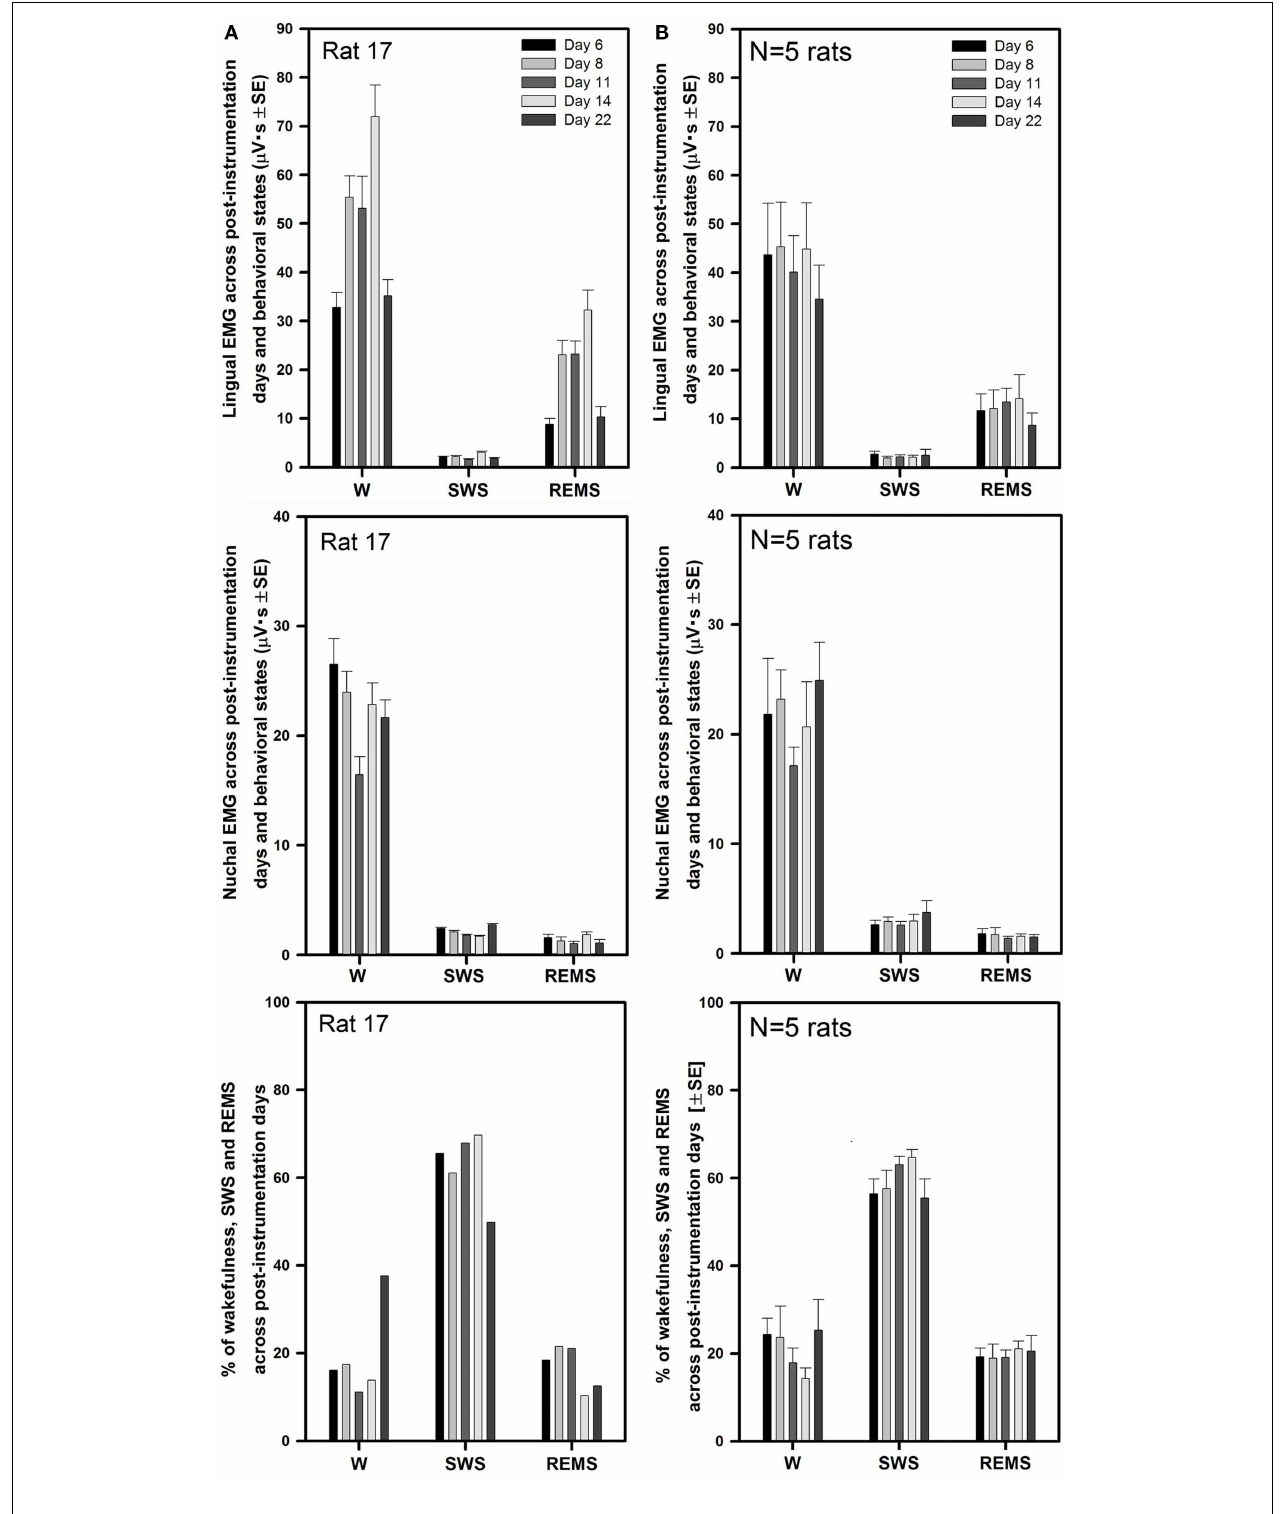
FIGURE 3 | Stable levels of lingual and nuchal EMGs across successive recording days in rats with intact upper airway . (A) Lingual and nuchal EMG levels quantified separately during different sleep–wake states, and the percentage amounts of wakefulness, SWS, and REMS in one rat across all five recording sessions conducted on days 6, 8, 11, 14, and 22 after instrumentation (rat 17 in Figure 1 ).